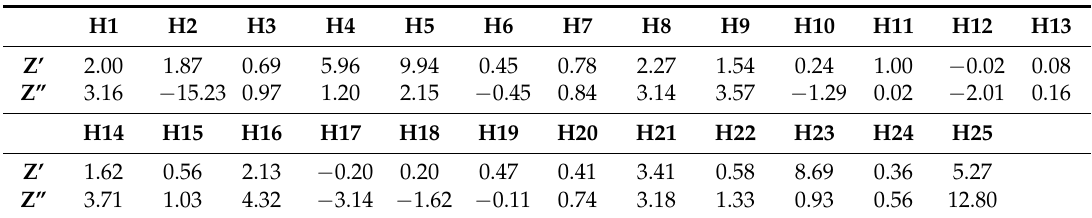
Table 7. Results of Altman